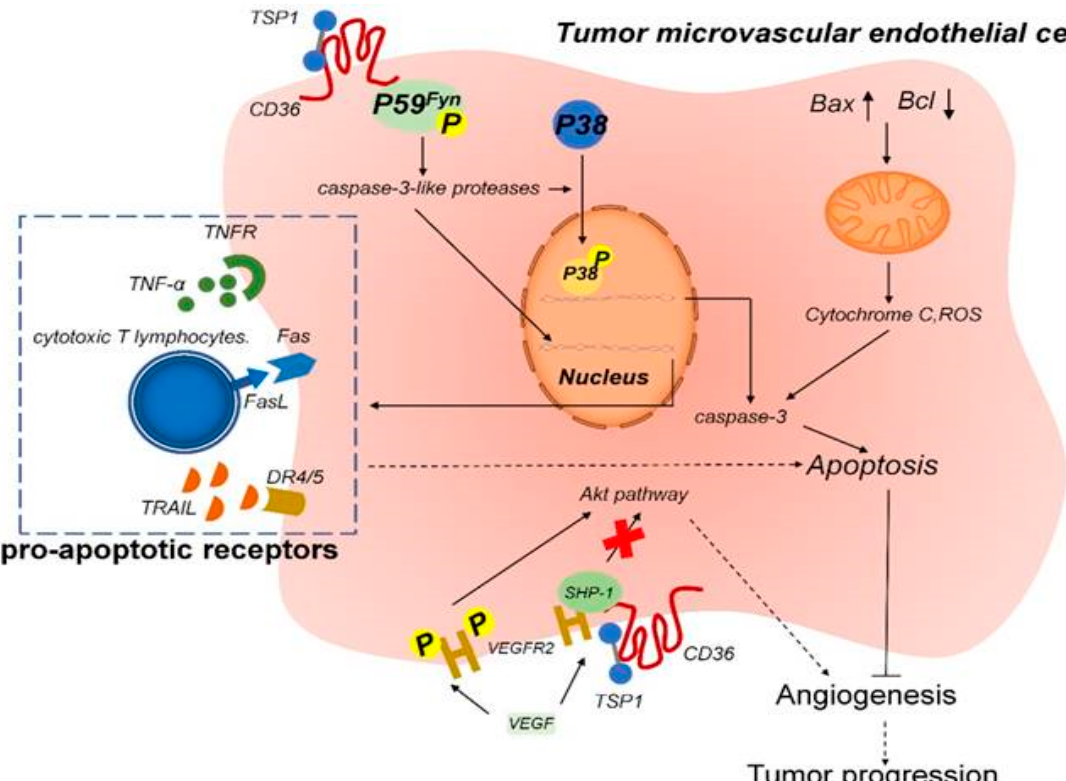
Figure 4. TSP-1-CD36 signaling is inducing apoptosis of tumor associated epithelial cells. As a result of TSP-1 binding to CD36 on microvascular endothelial cells, phosphorylation and, therefore, activation of P59fyn (cytoplasmic protein kinase) occur. This in turn stimulates caspase-like proteases, which induce the phosphorylation of MAPK. Nuclear translocation of MAPK generates increased expression of caspase-3 and of proapoptotic receptors, leading to apoptosis. Mitochondrial damage leads to the release of reactive oxygen species and of cytochrome C, which are also triggers of apoptosis. Moreover, the binding of THC-1 to CD36 induces the recruitment of SHP-1 to the VEGFR2 complex, followed by VEGFR2 dephosphorylation and inhibition of the VEGF pathway and leading to anti-angiogenesis. (Reproduced with permission from Reference